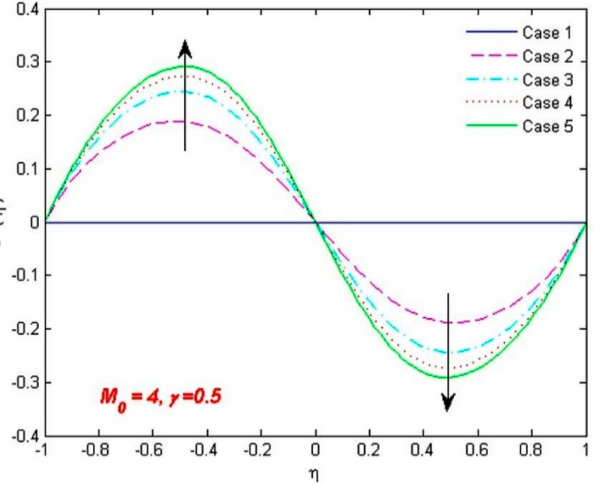
Figure 3. Change in angular velocity for various values of C 1 , C 2 and C 3 (shown in Table